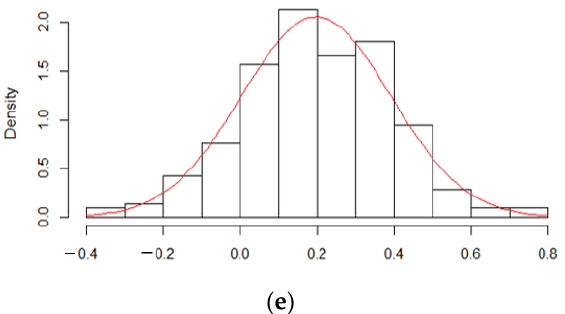
Figure 2. Normal distributions of the shape parameters derived from GEV estimates of the annual peak flows for the bridge collapse sites: ( a ) Appalachian Highland; ( b ) Central Lowland; ( c ) Interior Highland; ( d ) Coastal Plain; ( e ) All sites. Table 1. Descriptive statistics of the shape parameter values for the bridge collapse sites.